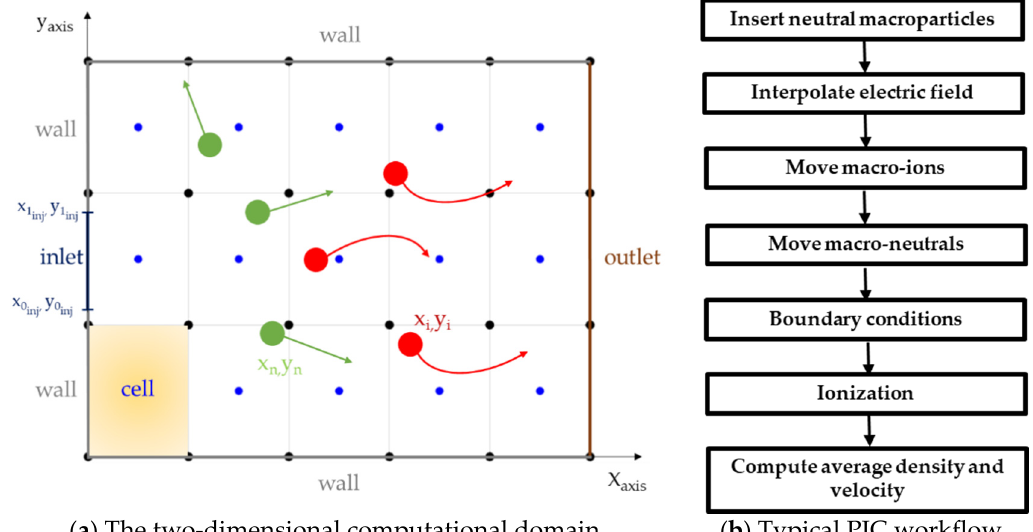
Figure 1. The two-dimensional computational domain. Blue, black, green, and red dots represent the cell centers, the nodes, the neutral macroparticles, and the ion macroparticles, respectively ( a ) and the typical PIC workflow ( b ).